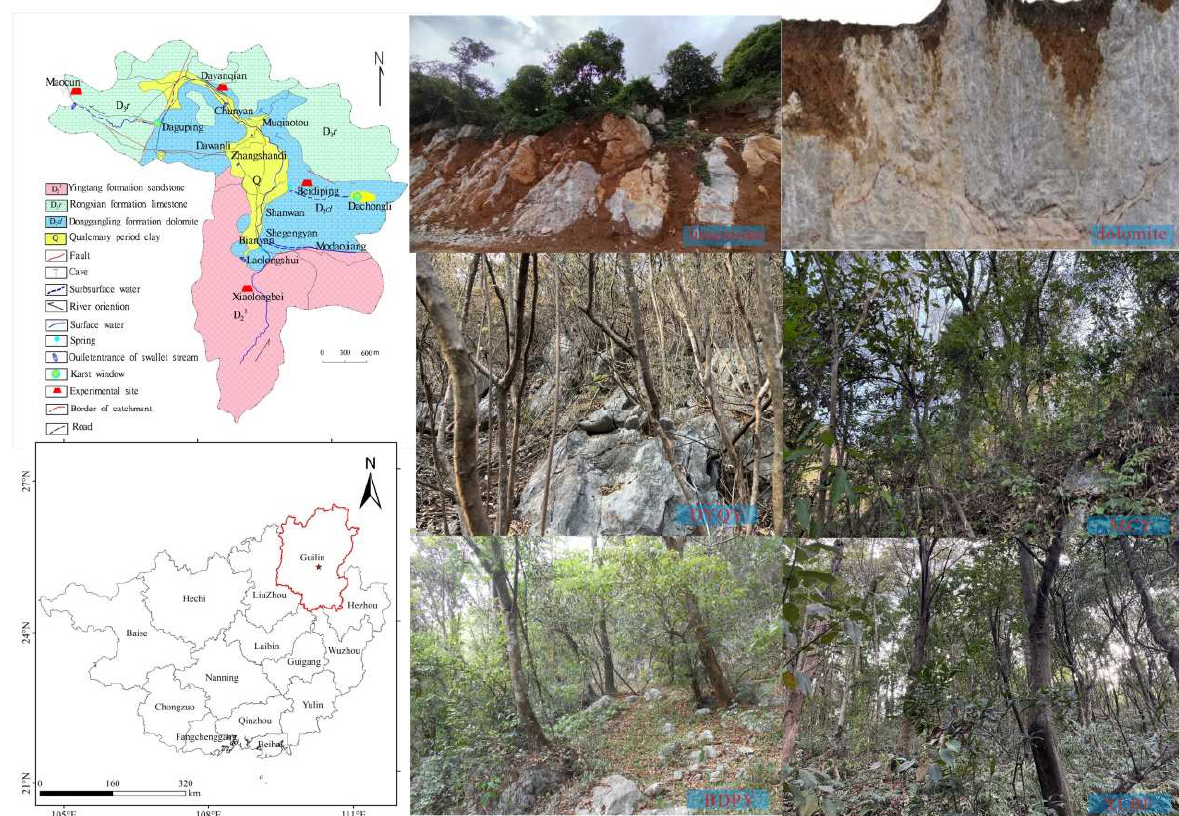
Figure 1. Study area location and panorama.